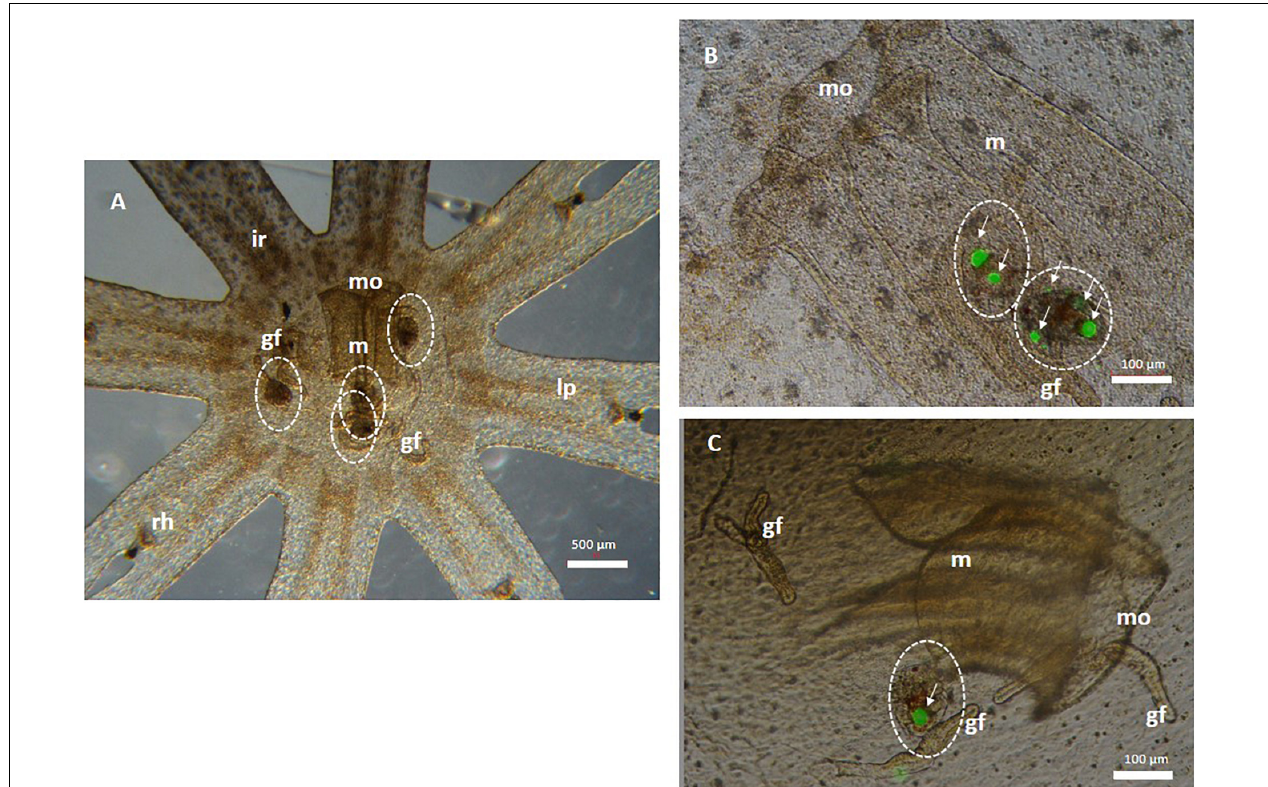
FIGURE 1 | Microplastic (MP) trophic transfer from T. fulvus nauplii (prey) to Aurelia sp. Ephyrae (predator) after a 24 h exposure. (A) Control Aurelia sp. ephyrae that ingested uncontaminated copepods (white dotted circles). (B,C) Copepods (white dotted circle) containing fluorescent polyethylene MPs (white arrows) are clustered in the manubrium of the mouth and near gastric filaments. mo, mouth; m, manubrium; ir, inter-radial; lp, lappets; rh, rhopalia; gf, gastric filaments; white dotted circle, copepod; white arrows, MPs (or aggregate).